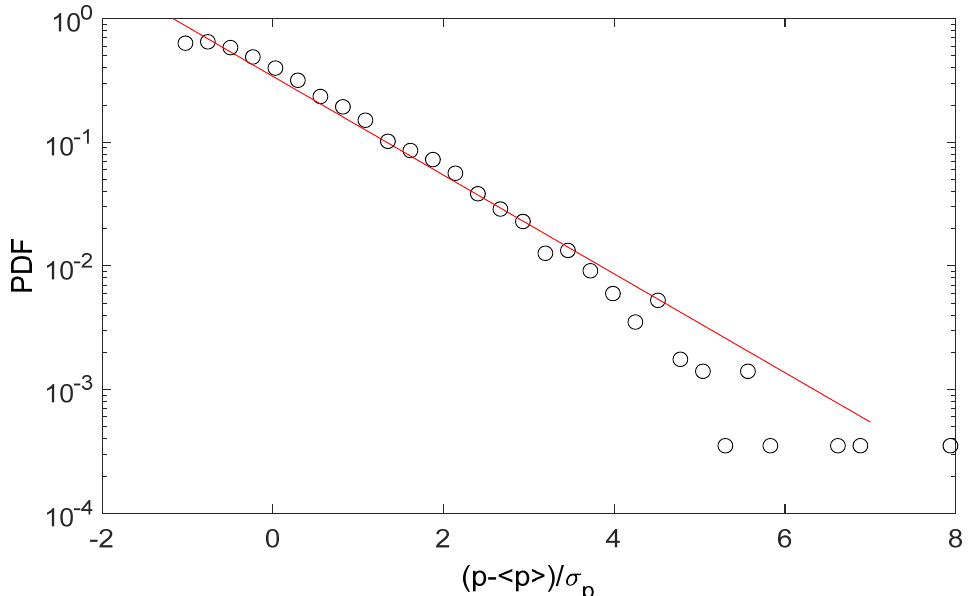
Figure 7. PDF of the intermittency time ∆ t computed from a signal extracted randomly from the entire database (circles) and the analytical prediction provided in [26] (red line).